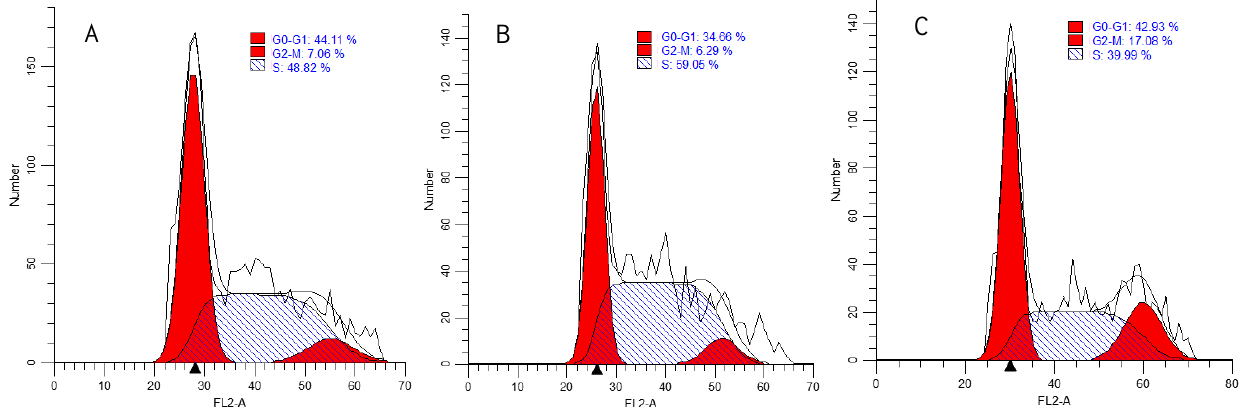
Figure 5. Flow cytometric analysis of cell cycle parameters: HepG2 liver cancer cells were incubated for 24 h; ( A ) control; ( B ) 2.4 µM (IC 50 ) of NO- ∆ -16-CIEA 14a ; ( C ) 8.1 µM (IC 50 ) of NO- ∆ -16-CIEA 14b .